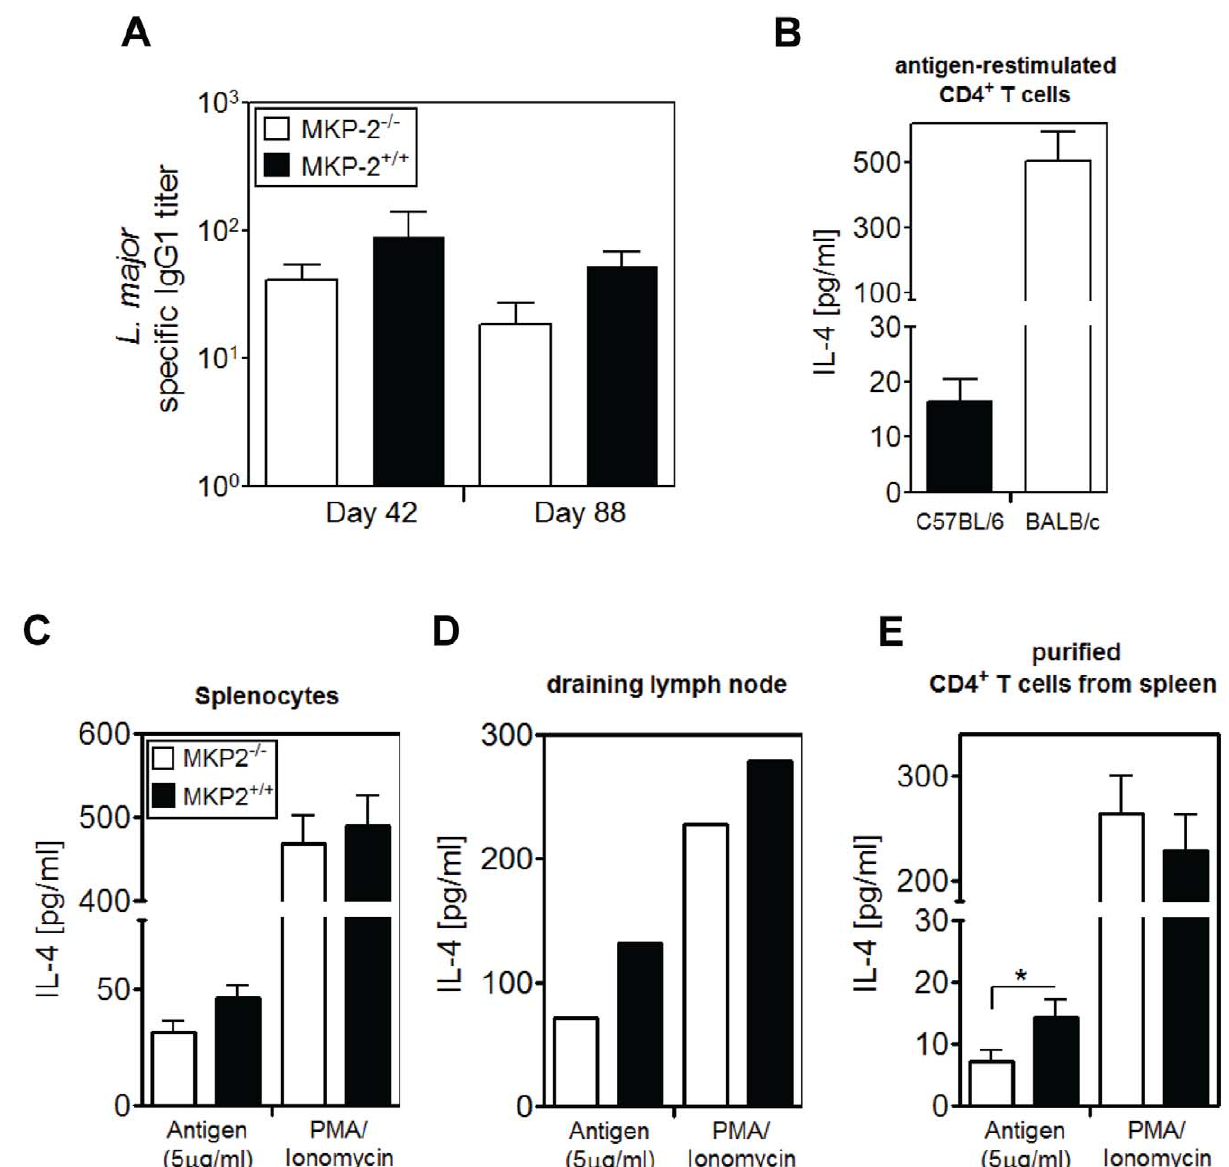
Figure 4. MKP-2 deficient mice infected with L.major have a reduced T H 2 response. Serum of L. major infected MKP-2 2 / 2 (open column) and MKP-2 + / + (closed column) mice was analysed for parasite-specific antibody isotype IgG1 (A). The titres were calculated as reciprocal dilution of the half-maximal absorption at 450 nm. In order to measure T H 2 responses, 3 MKP-2 2 / 2 , 3 MKP-2 + / + and 3 BALB/c mice were given 2 6 10 6 L. major promastigotes subcutanteously into the hind foot pad. At peak of infection, mice were sacrificed and spleen and popliteal lymph node removed. Spleens were analysed individually and lymph nodes pooled within each group. CD4 + T cells were magnet-purified from spleens using a negative isolation kit. Splenocytes (B, C), lymph node cells (D) and purified CD4 + T cells (E) were re-stimulated either with antigen pulsed DC,